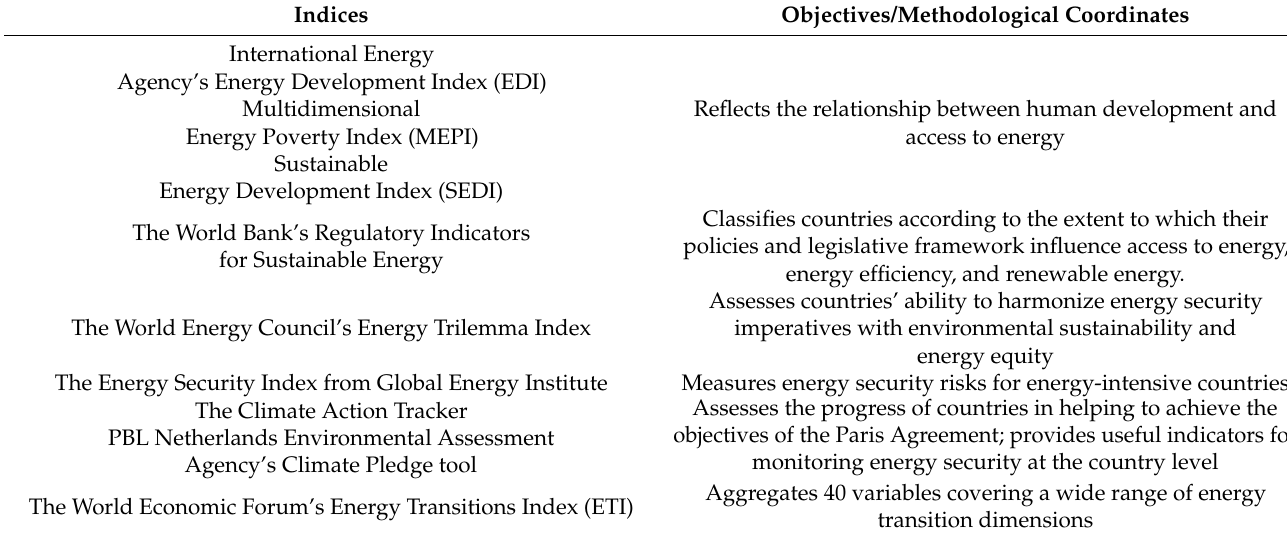
Table 1. Aggregate indicators of the energy